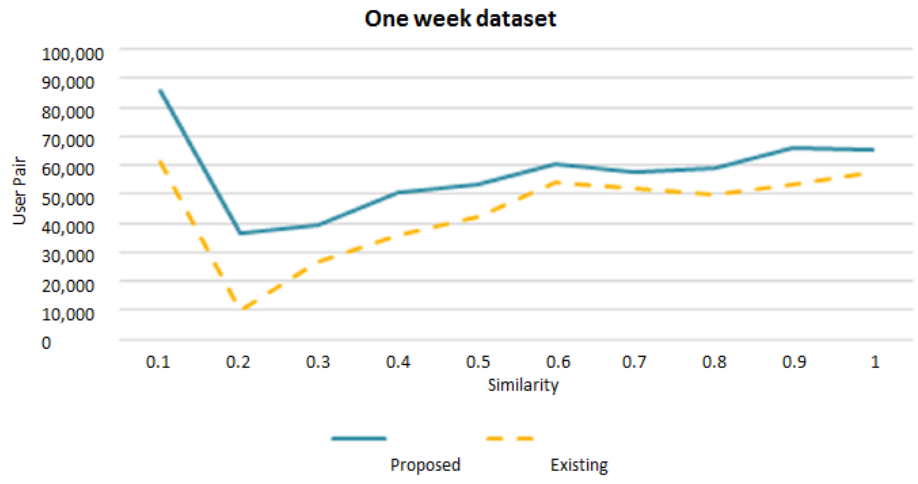
Figure 5. SAA approach similarity comparison with existing